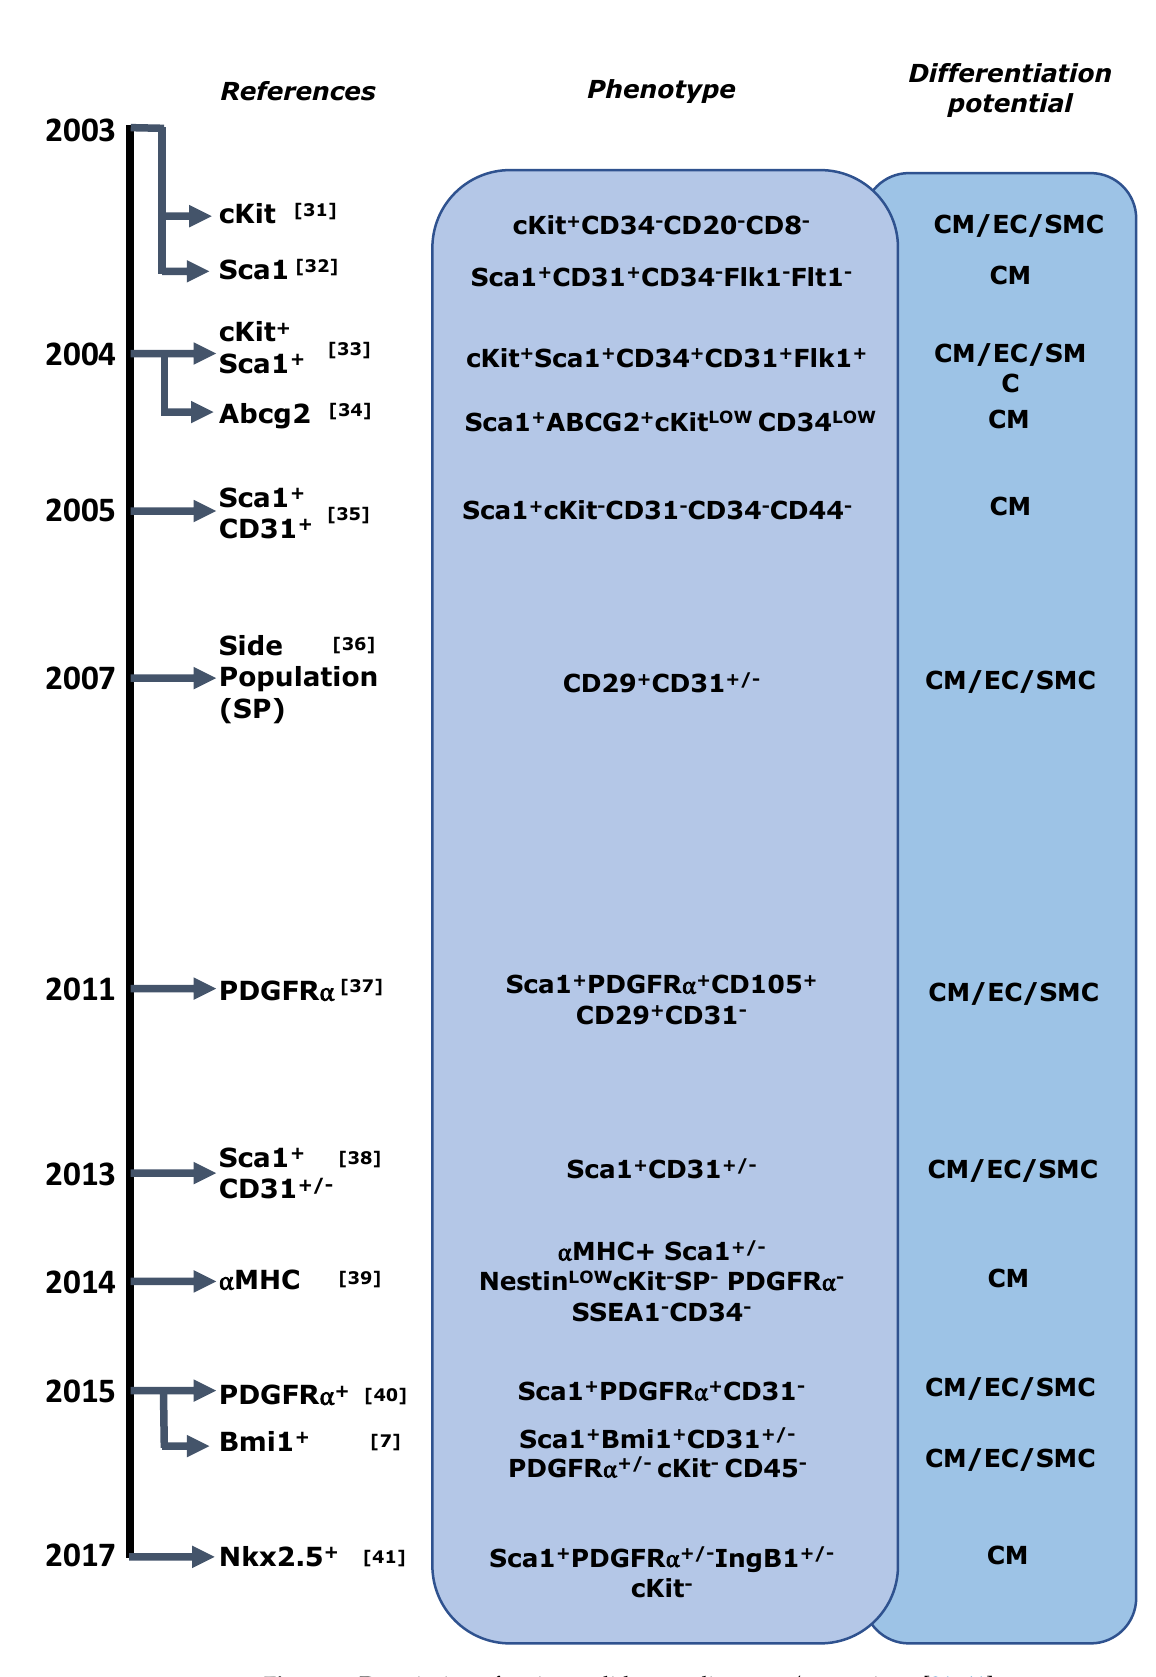
Figure 2. Description of main candidate cardiac stem/progenitors